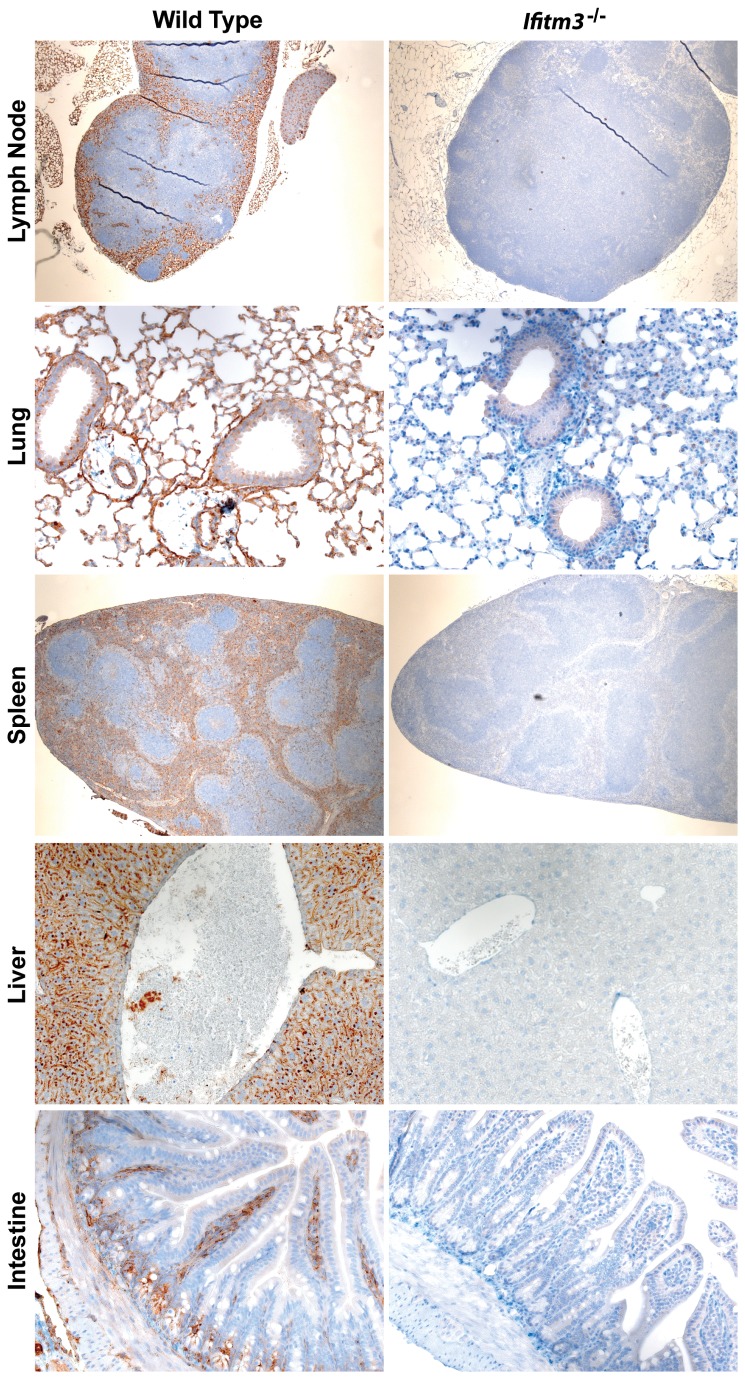
Expression of Ifitm3 at the predominant sites of pathogen infection.Paraffin-embedded sections from wild type and Ifitm3-/- mice were cut and stained for expression of Ifitm3 (brown), and counterstained with hematoxylin (blue). Original magnification of lymph node and spleen 10×; lung and intestine 20×; liver 40×.